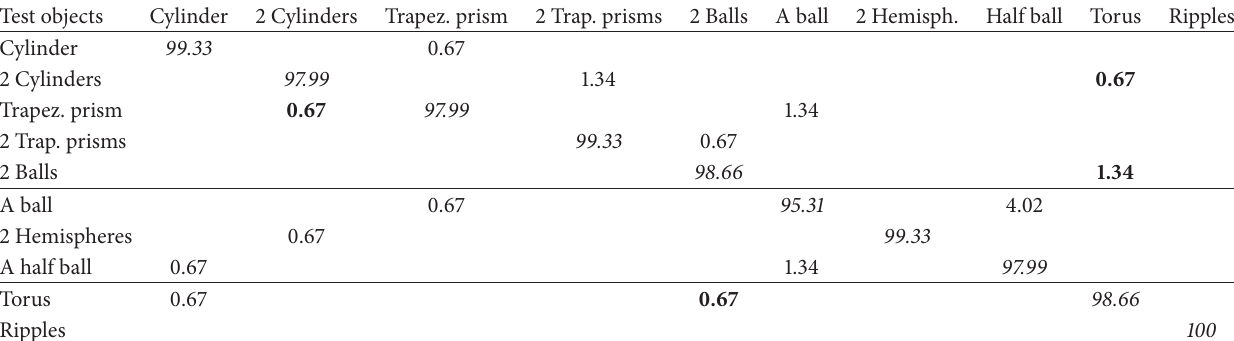
Table 3: Confusion matrix of recognition and identification (%) of virtual shapes in the parallel scanning mode at the playback velocity of the virtual trajectory of 42mm/s, averaged over all